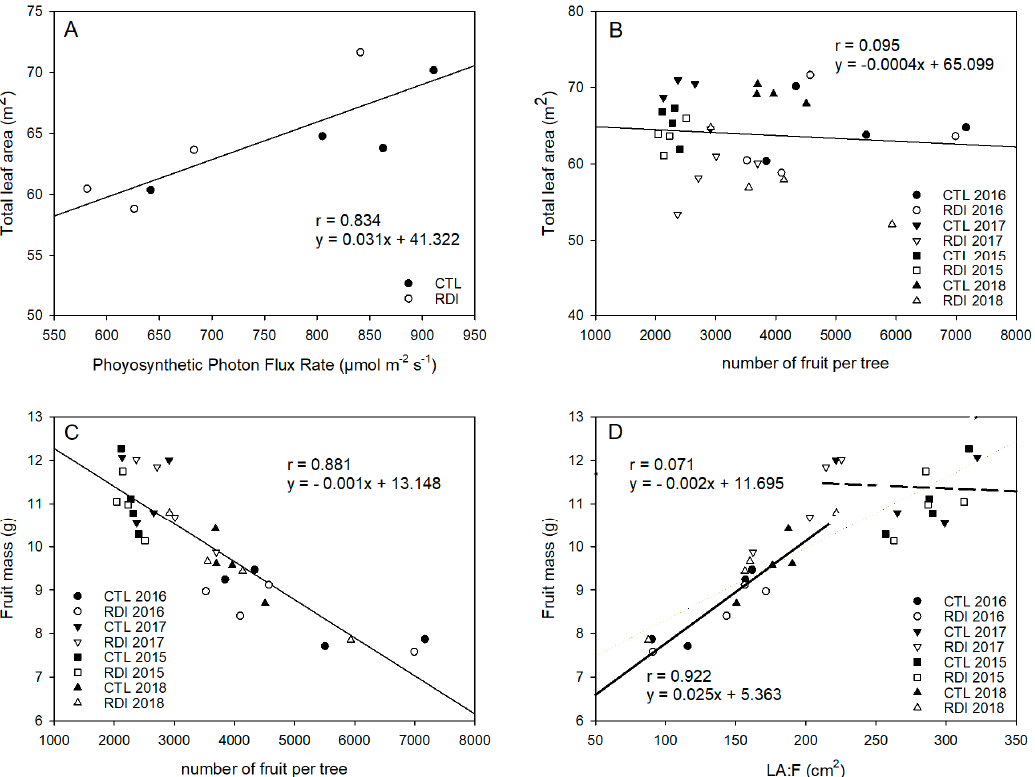
Figure 4. Relationships between photosynthetic photon flux rate and tree total leaf area ( A ), number of fruit per tree and total leaf area ( B ), number of fruit per tree and fruit unitary mass ( C ), leaf area:fruit ratio (LA:F) and fruit unitary mass ( D ). Each observation corresponds to an average value for each block (n = 3).